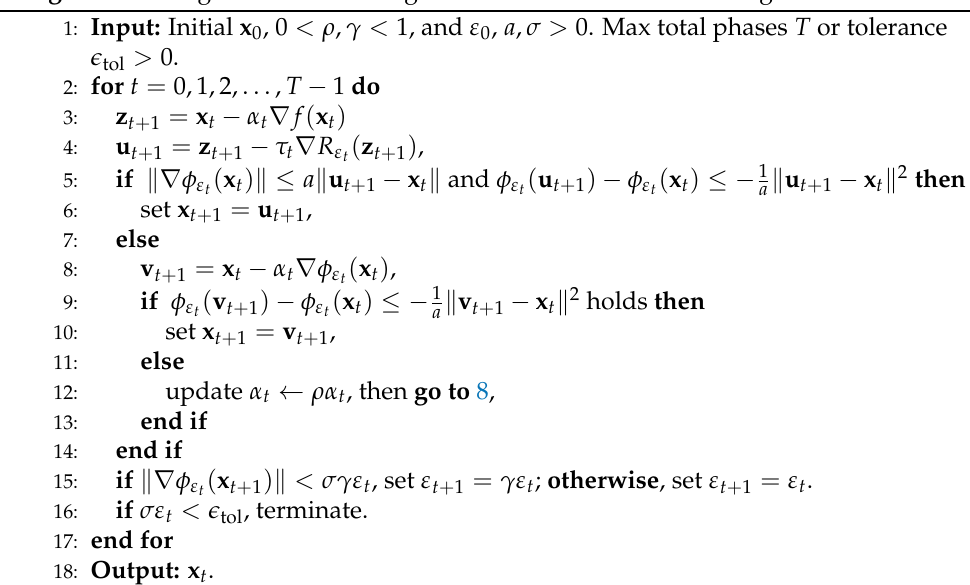
Algorithm 1: Algorithmic Unrolling Method with Provable